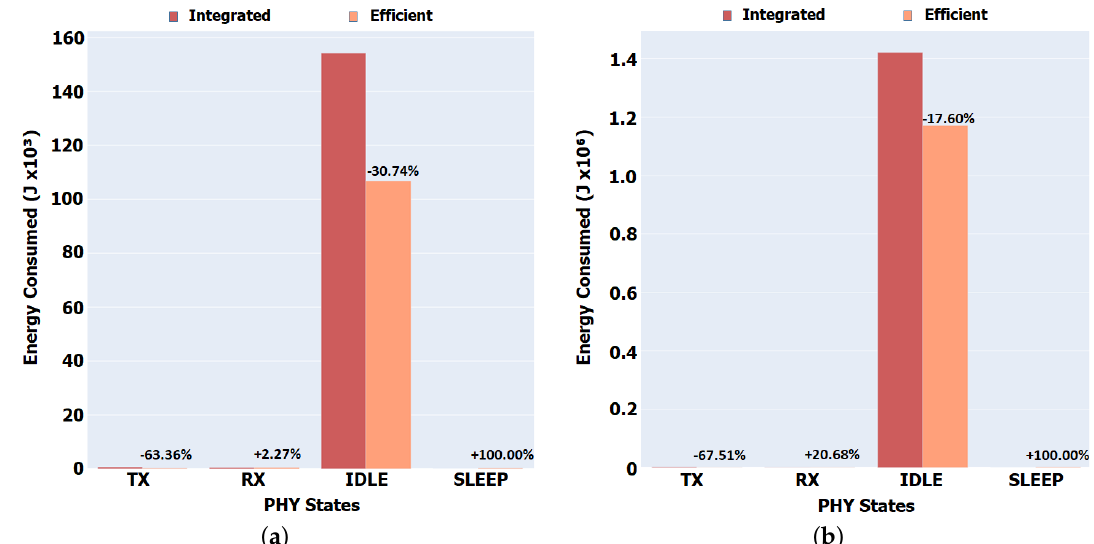
Figure 12. Total energy consumed in each PHY state. ( a ) Aveiro scenario. ( b ) Porto scenario. The increase in the time in receiving mode (Rx) is due to the fact that there are fewer packets circulating in the network, meaning that the increase in the reception energy consumed is for the Data packets that successfully reach the Consumer. A reduction of between 17% (Porto scenario—Integrated IDLE = 1,420,309, Efficient IDLE = 1,170,393) and 30% (Aveiro scenario—Integrated IDLE = 154,149, Efficient IDLE = 106,768) in the energy consumption performed in idle mode is also visible, as the time spent in this state was converted into consumption in Sleep